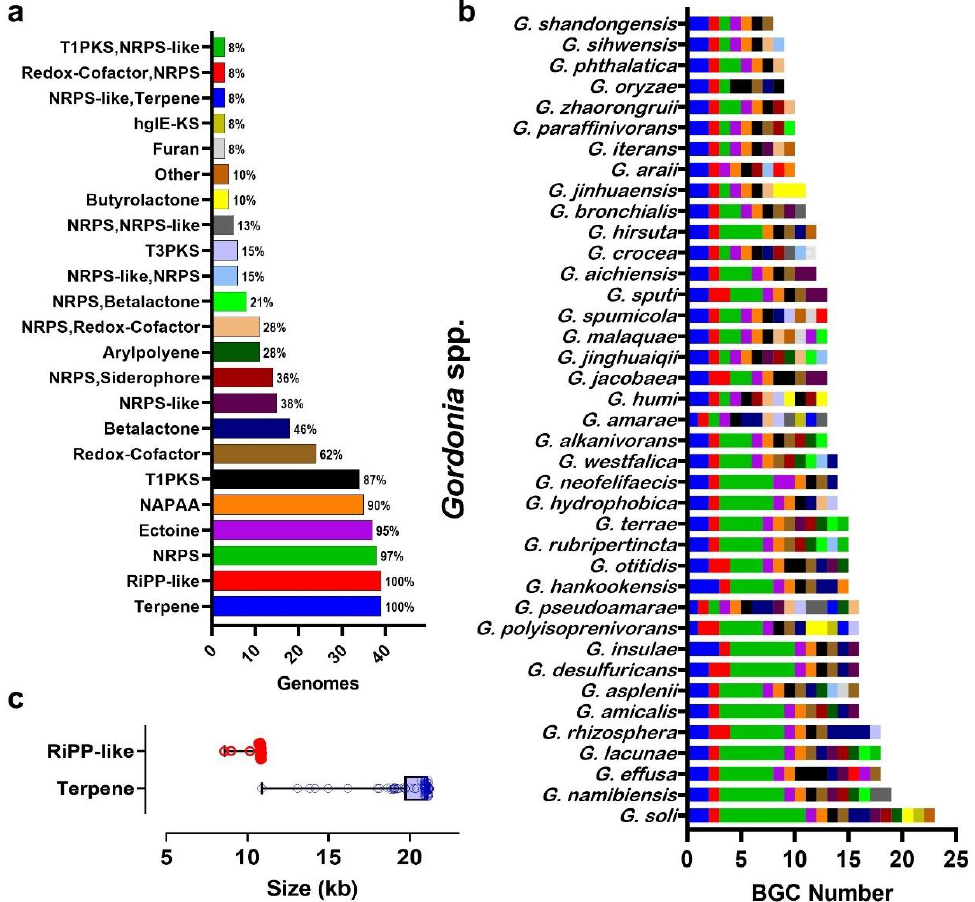
Figure 9. Biosynthetic gene cluster content of species of the genus Gordonia . ( a ) The 23 most frequent BGCs (at the front of each bar is the prevalence among the 39 species studied), ( b ) the number of predicted BGCs in the genome of each Gordonia species (the color code corresponds to the classification indicated in Figure 9a; for a detailed list see Table S9), ( c ) size in kb of the BGCs occurring in all the genomes studied (i.e., RiPP-like and Terpene).